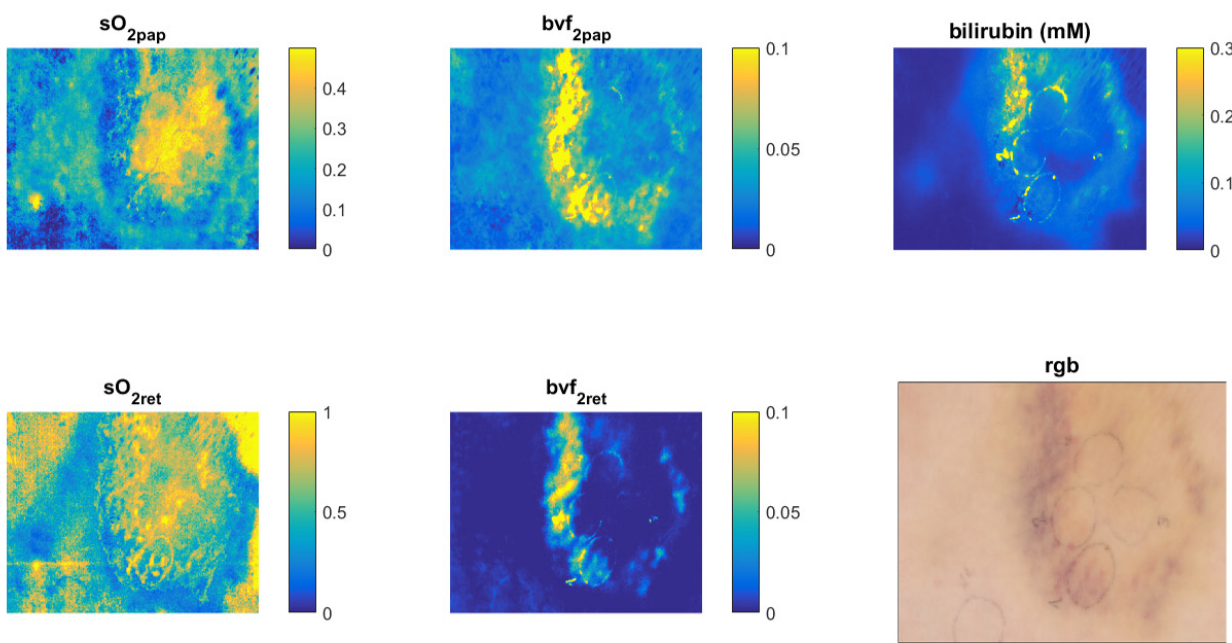
Figure 14. An example of utility of the custom-made laboratory hyperspectral imaging (HSI) system, with shown tissue property maps of a skin bruise extracted from a hyperspectral image using the Inverse Diffuse Approximation Algorithm. The presented tissue parameters are: sO 2pap —blood oxygenation in the papillary dermis, sO 2ret —blood oxygenation in the reticular dermis, bvf 2pap — blood volume fraction in the papillary dermis, bvf 2ret —blood volume fraction in the reticular dermis, bilirubin (mM)–bilirubin concentration in the dermis, and RGB—an RGB image of the bruised skin. All quantities are fractions without units, except bilirubin, which has millimolar units